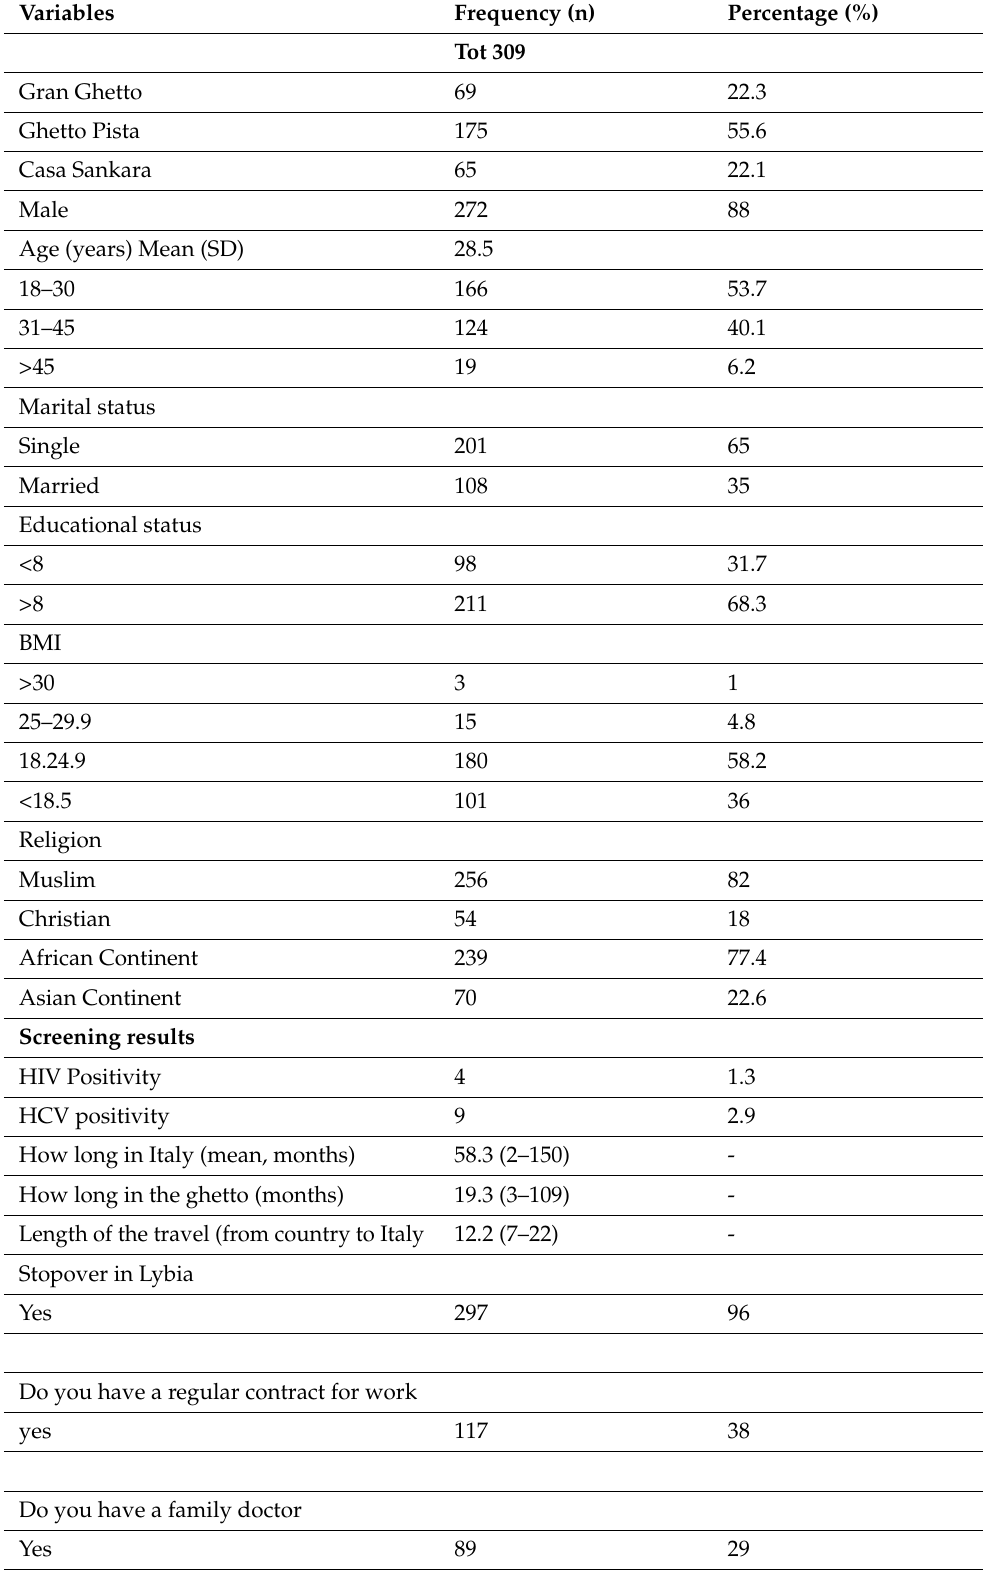
Table 1. Baseline sociodemographic characteristics of 309 agricultural migrant workers who partici- pated in the KAP (knowledge, attitude and practices) survey and screening for HIV-HCV.